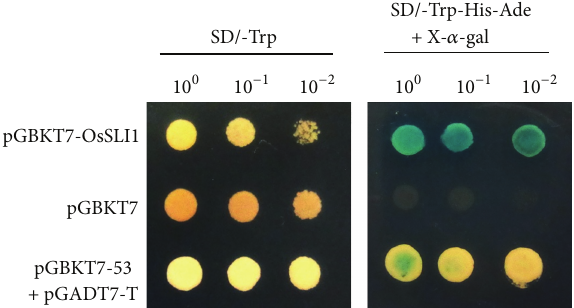
Figure 7: Transcriptional activation analysis of OsSLI1 in yeast. The recombinant vector pGBKT7-OsSLI1 was transferred into yeast strain AH109. Transcriptional activation ability of OsSLI1 was analyzed by grown on SD/-Trp and SD/-Trp-His-Ade/5 mM 3-AT plates. Negative control: yeast strain AH109 with pGBKT7 vector; positive control: yeast strain AH109 with pGBKT7-53 and pGADT7- T vectors.